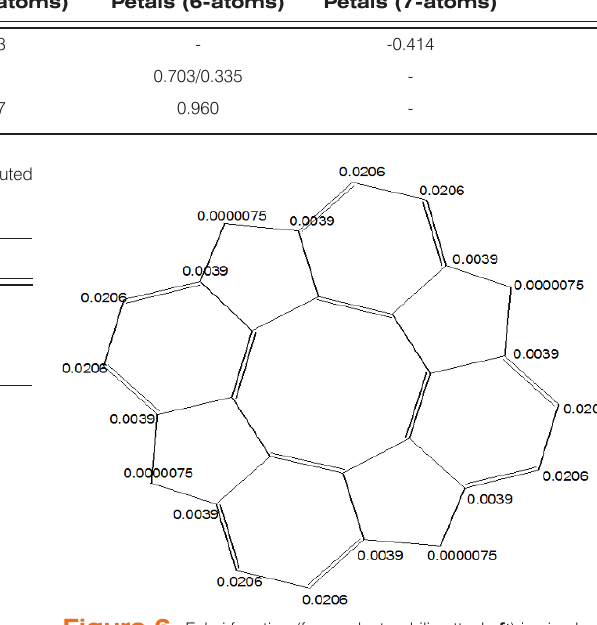
Figure 6. Fukui function (for an electrophilic attack, f + ) in circulene 1c